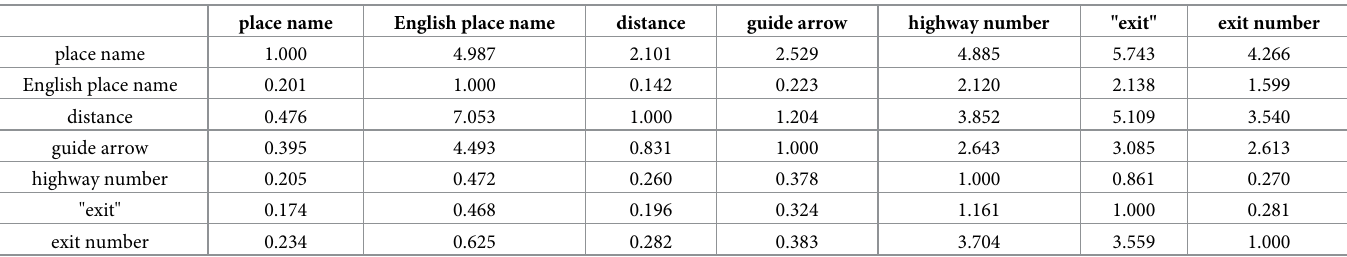
Table 6. Judgment